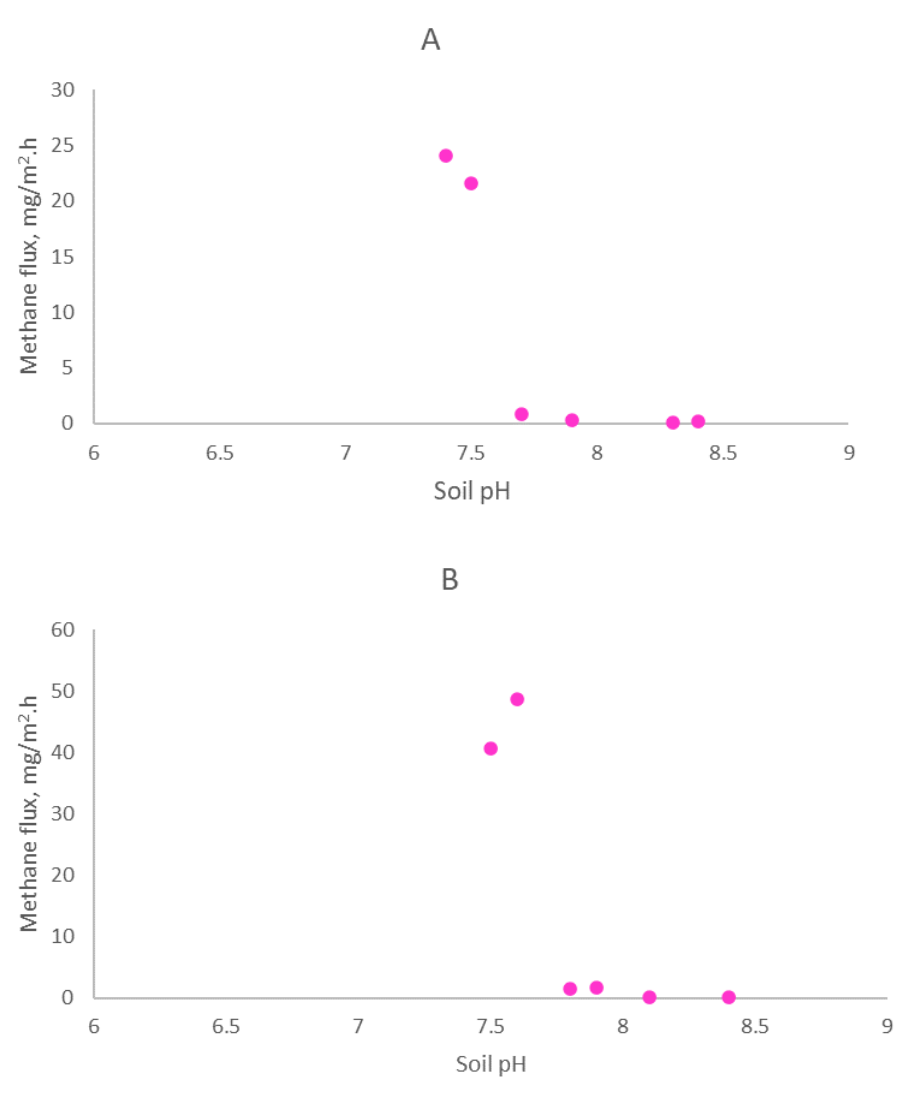
Figure 4. Relationship between the methane emissions and pH for the cultivation CO 45 grown in Manjakuppam during ( A ) wet and ( B ) dry Manjakuppam during ( A ) wet and ( B ) dry seasons.